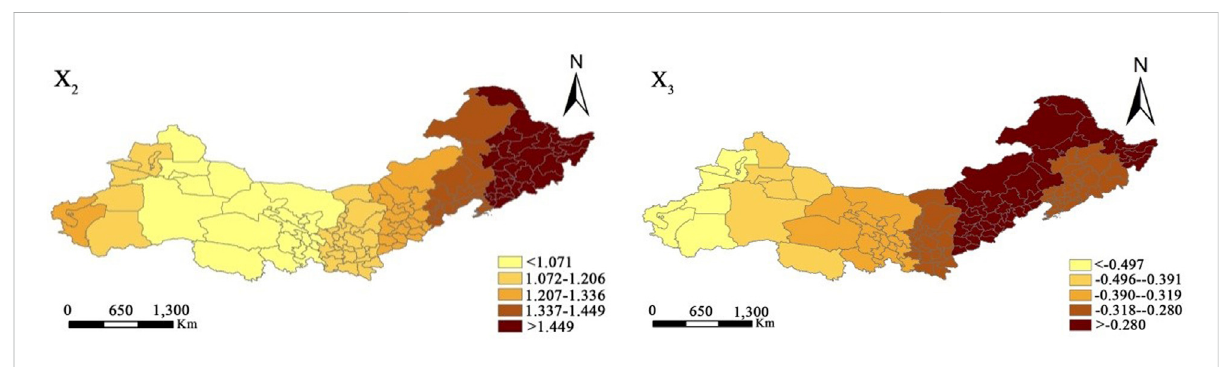
FIGURE 6 Spatial Distribution of Regression Coef fi cient s of the GWR Model